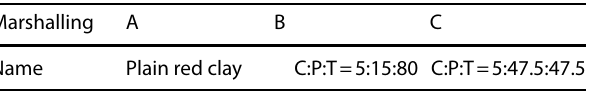
Table 5 Ratio of dynamic test